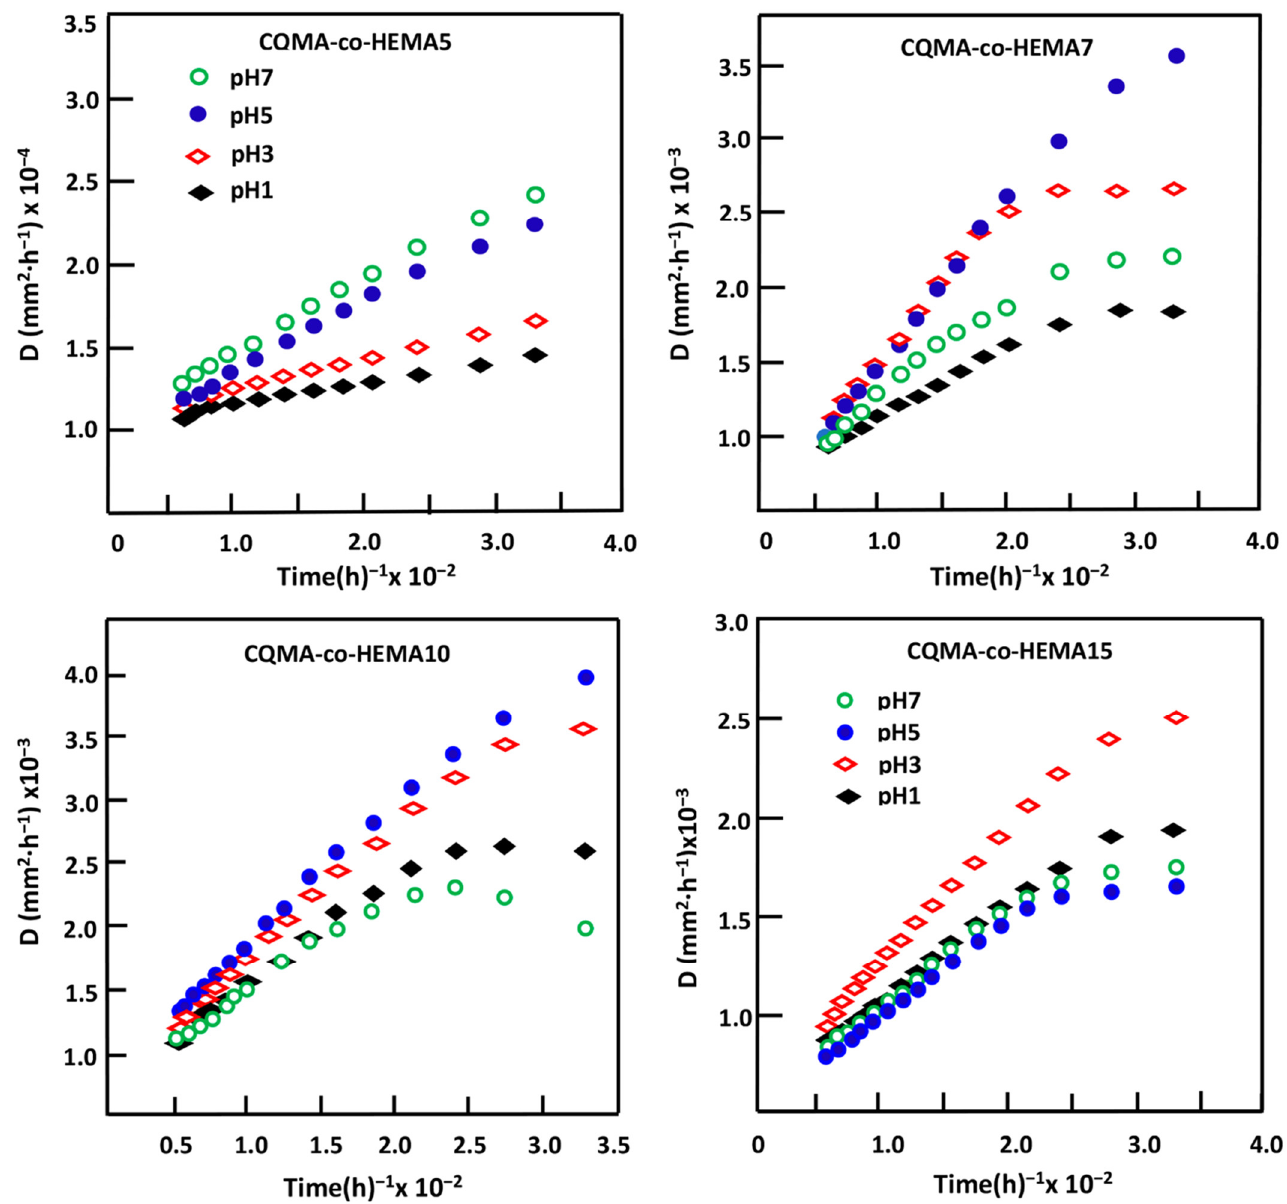
Figure 16. Variation of the diffusion factor of HCQ in HCQMA-co-HEMA systems versus reverse time.